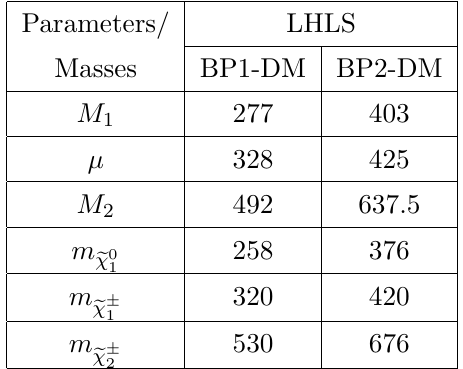
Table 7 . BPs consistent with the LHC, a (cid:22) and DM relic density constraints as derived in section 5. All masses and mass parameters are in GeV.